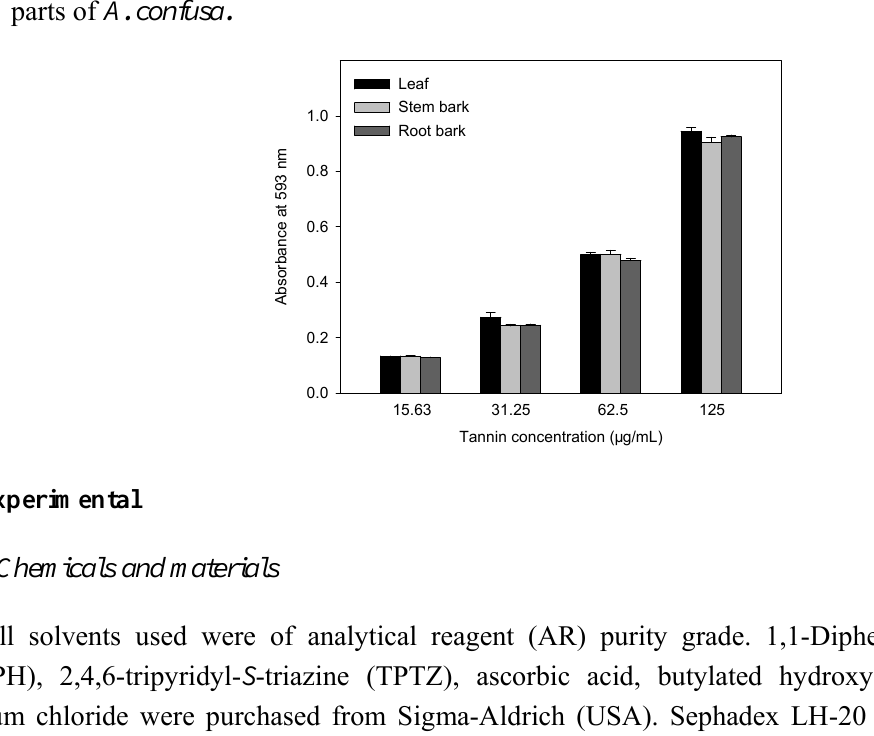
Figure 4. Ferric reducing power after addition of the condensed tannins from different parts of A.